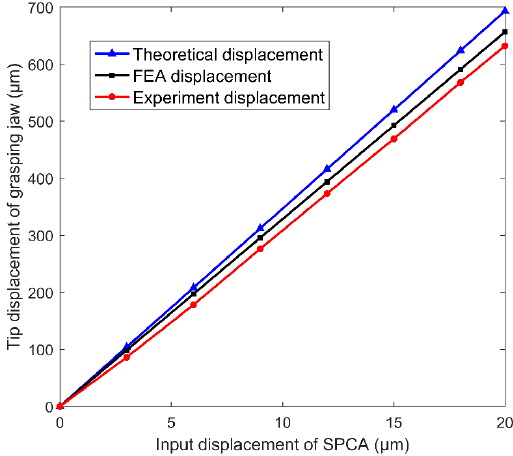
Figure 12. SPCA input displacement versus the tip displacement of the grasping jaw. Table 2. Experiment results of displacement amplification.